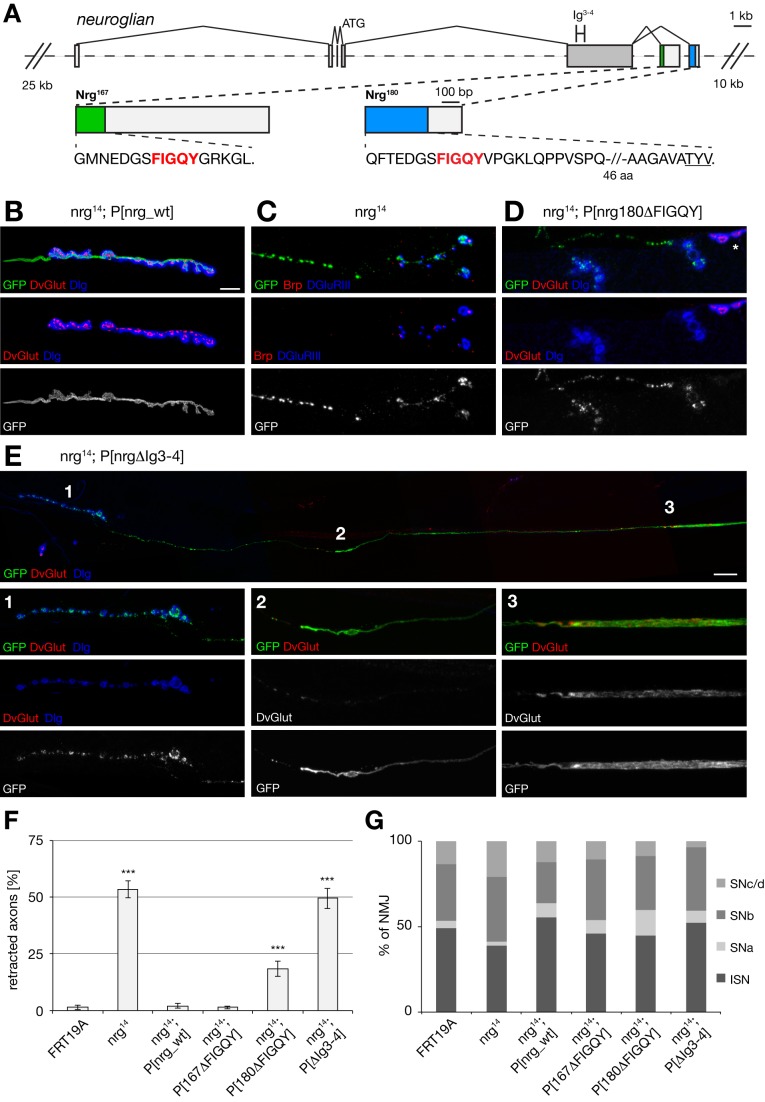
MARCM analysis demonstrates requirement of extra- and intracellular domains of Nrg180 for synapse stability.(A) Overview of the genomic locus of nrg. The Pacman construct spans 92 kb including the endogenous enhancer elements up- and downstream of nrg. The Nrg167- and Nrg180-specific exons and the relevant amino acid sequences are depicted. The position of the common Ig-domains 3 and 4 is indicated. The isoform-specific FIGQY sequences are highlighted in red and the PDZ protein-binding motif of Nrg180 isoform is underlined. (B) A nrg14 MARCM clone rescued by a wild-type nrg Pacman construct. The motoneuron clone was marked by the expression of mCD8–GFP (green). Synaptic vesicles (DvGlut, red) were found opposite postsynaptic Dlg (blue), indicating a stable NMJ. (C) A nrg14 MARCM clone showing a synaptic retraction. Only fragmented remnants of the membrane GFP marker were still present at a nerve terminal that almost completely lacked the presynaptic active zone marker Brp (red). Postsynaptic glutamate receptor clusters were still present. In addition, the axonal membrane prior to the NMJ was also fragmented. (D) A nrg14 MARCM clone expressing only Nrg180 lacking the FIGQY motif. The mutant (GFP-positive) NMJ was retracted while a neighboring control NMJ (asterisk) remained stable. (E) Composite image overview of an nrg14 MARCM clone expressing a mutated form of Nrg180 lacking the extracellular Ig3–4 domains. Three areas are shown at larger magnification in 1–3. (E1) At the NMJ no presynaptic vesicles were present opposite postsynaptic Dlg. The Dlg staining was no longer interconnected and only remnants of the presynaptic membrane marker mCD8–GFP were visible, indicating a complete elimination. (E2) Approximately 150 µm proximal from the NMJ, the axon ended in a “bulb-like” structure. Between the “bulb-like” axon ending and the NMJ, only punctate staining of the membrane marker was visible. (E3) At a significant distance from the “bulb,” a large axonal swelling was visible that contained aggregates of the synaptic vesicle marker DvGlut. (F) Quantification of mCD8-marked axons that were not connected to target muscles in the indicated genetic background. The nrg14 mutant phenotype was significantly rescued by the presence of a wild-type nrg Pacman construct, a nrg construct lacking the FIGQY domain of Nrg167, and only partially rescued by P[nrg180ΔFIGQY] and not rescued by P[nrg180ΔIg3–4]. (G) Analysis of muscle innervation pattern of motoneuron MARCM clones that were connected to postsynaptic muscles. In all genotypes we observed normal innervation patterns for all four major classes of motoneurons. Scale bar in (B) corresponds to (B-D), 10 µm. Scale bar in (E), 20 µm. Error bars represent SEM.